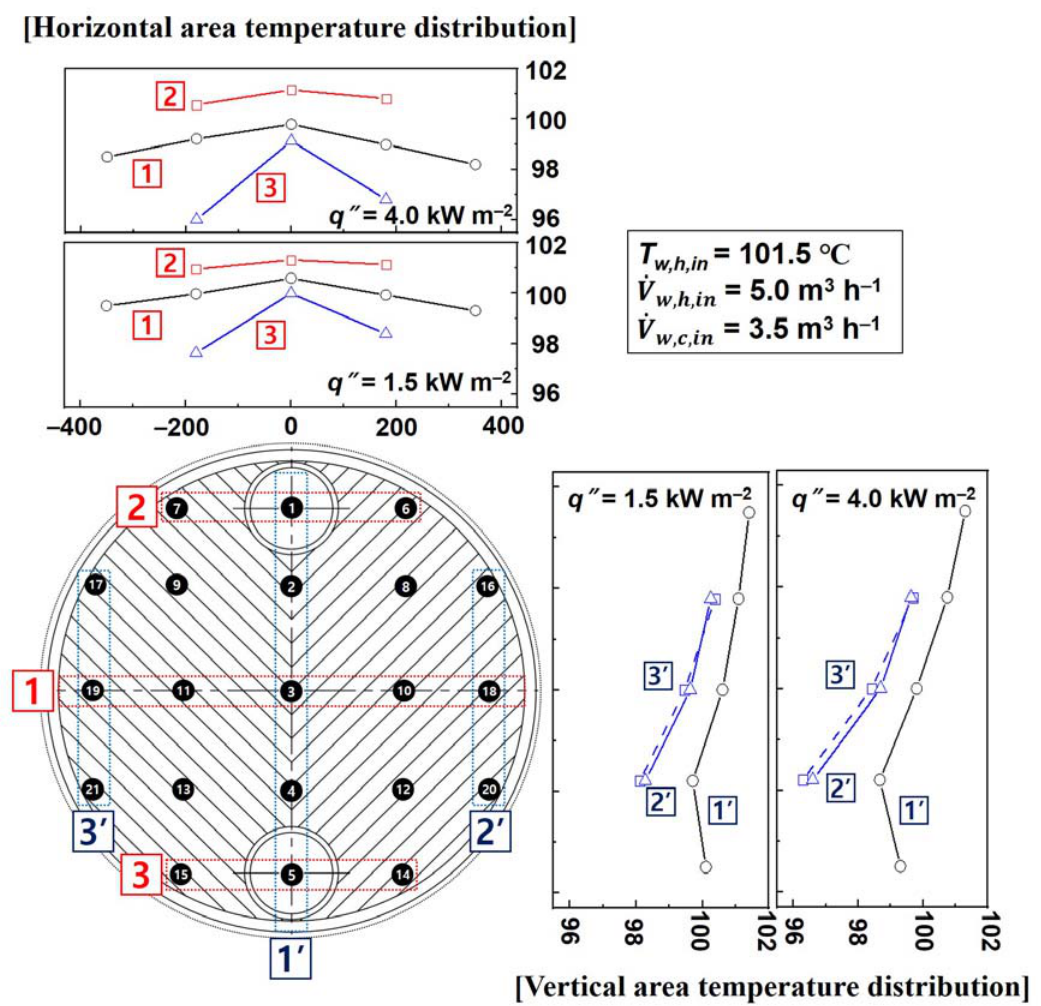
Figure 16. The horizontal and vertical temperature profiles with respect to heat flux.